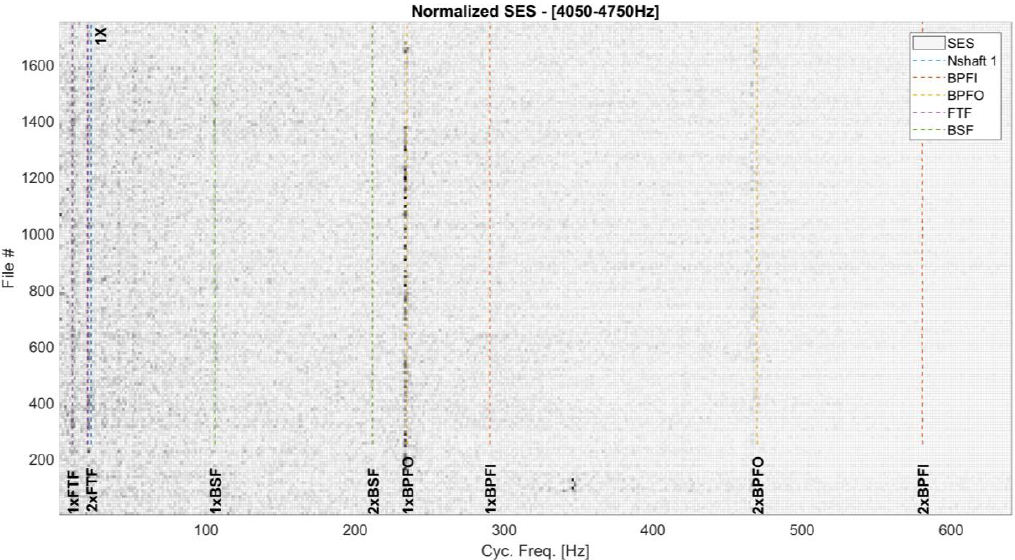
Figure 17. Normalized SES map, second frequency band—right TB.